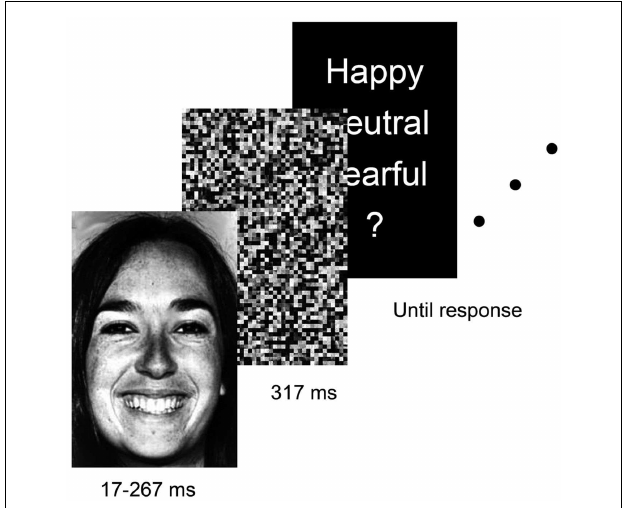
FIGURE 1 | Example of the stimulus presentation sequence in the masked recognition task. Target pictures were shown for durations of